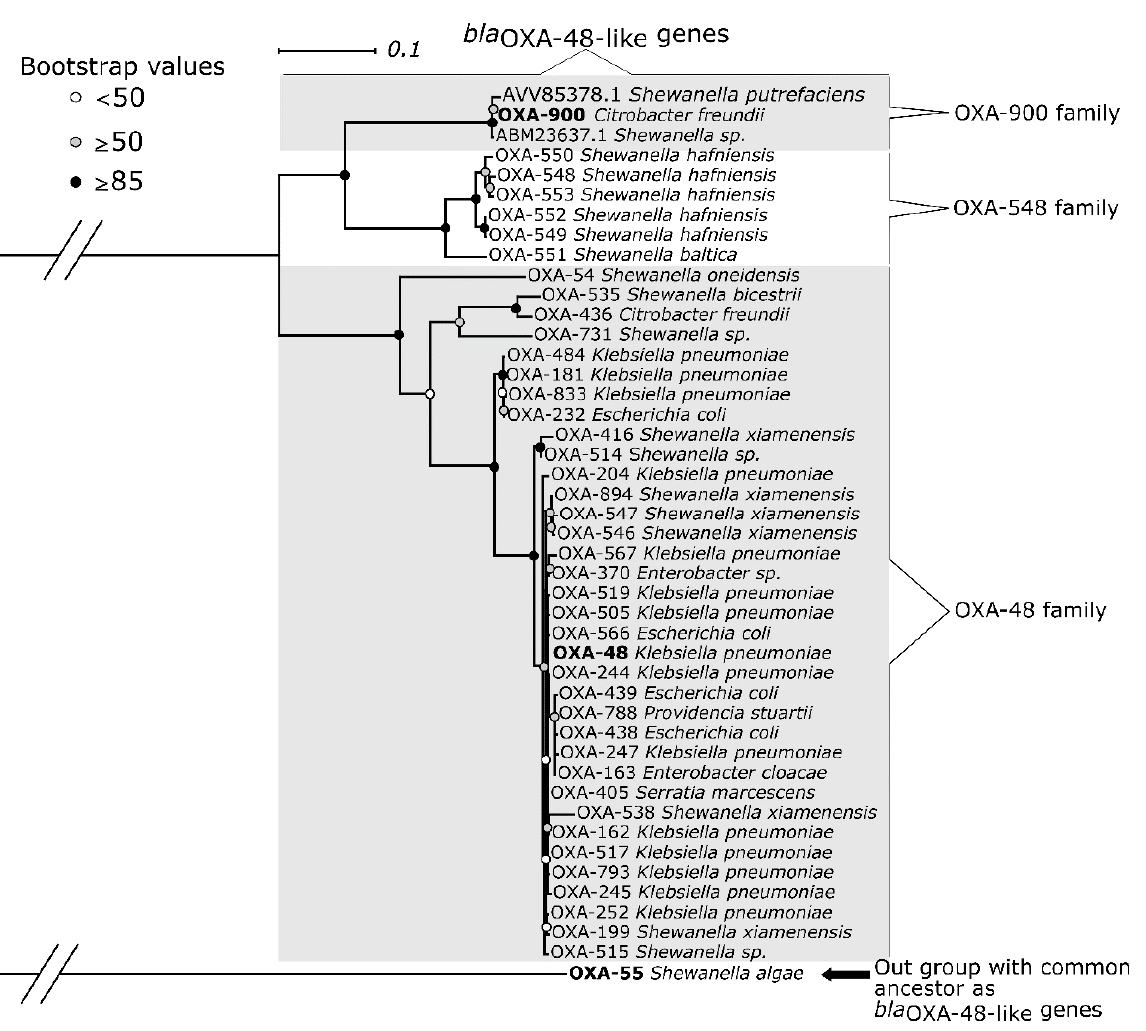
Figure 1. Maximum Likelihood phylogenetic tree analysis of all bla OXA that diversify from bla OXA-55 found at the NCBI’s Bacterial Antimicrobial Resistance Reference Gene Database. Two sequences from environmentally isolated Shewanella were also included, the first from S. putrefaciens isolated from Litopenaeus vannamei (whiteleg shrimp) in China (AVV85378.1) and the second (ABM23637.1) from Shewanella sp. from the marine environment.